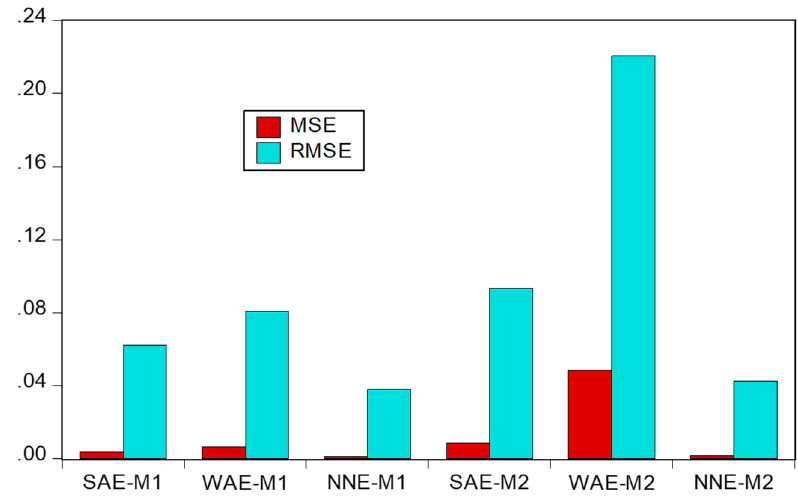
Figure 13. Error bar plots (SAE-M1, WAE-M1, and NNE-M1) for TDS.